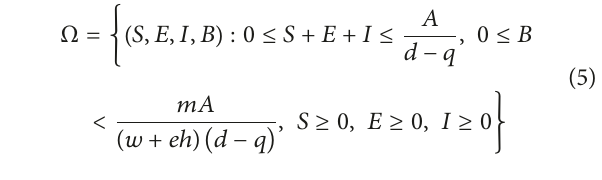
Table 2: The description of new parameters in model (4). Parameter Description